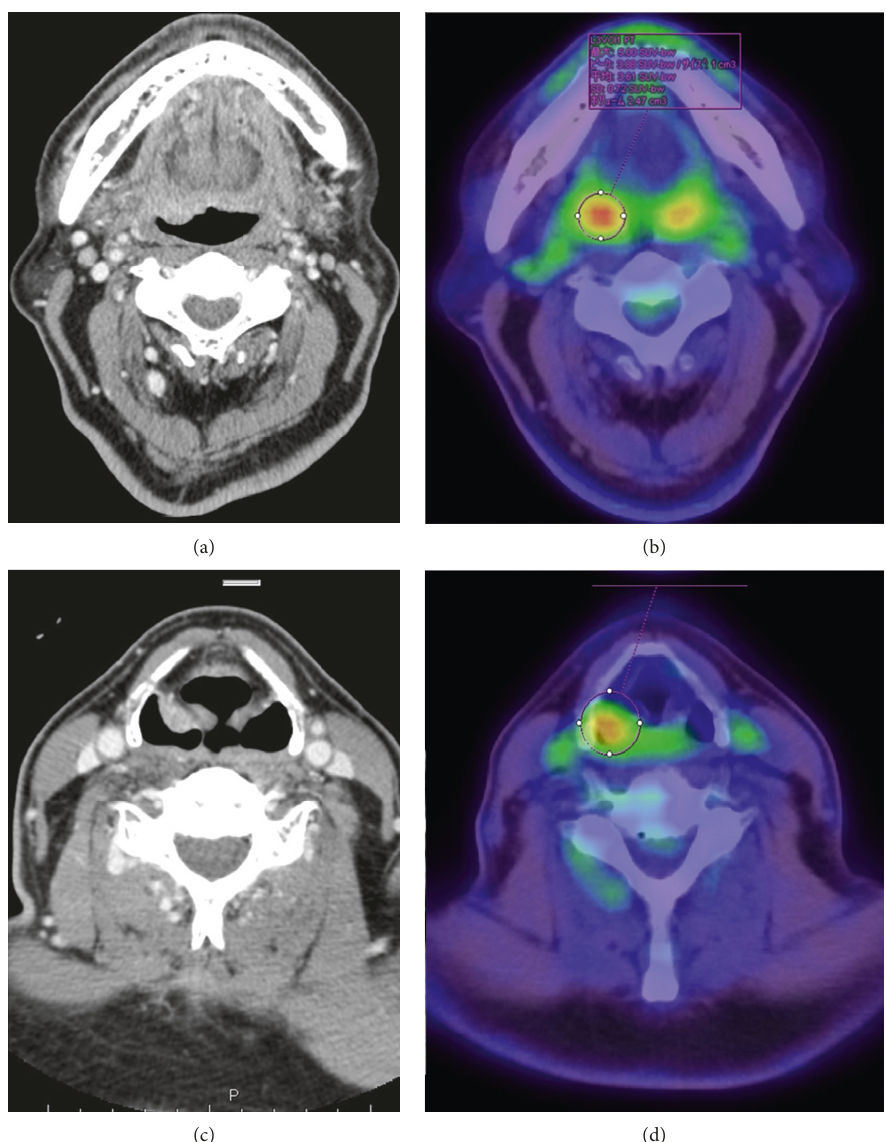
Figure 2: Contrast-enhanced CTand FDG PET/CT. Thickening of the pharyngeal wall with irregular contrast enhancement is observed on the right side of the tongue base and in the right piriform recess. SUVmax is 2.0 on the right side of the tongue base and 4.2 in the right piriform